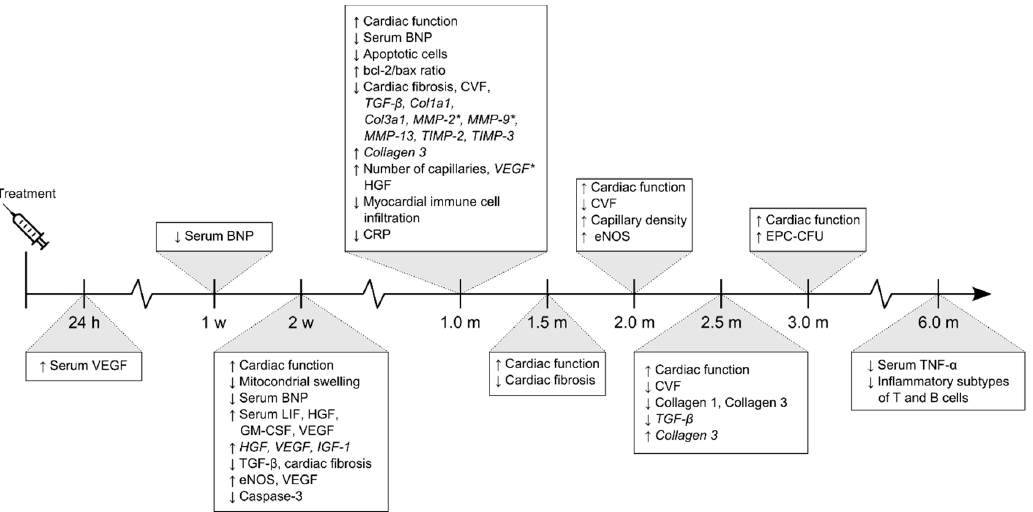
Figure 4. Timeline illustrating functional and molecular outcomes investigated in the included studies. Five studies investigated molecular outcomes within the first four weeks after treatment, whereas the remaining investigated at one-month post treatment or later. Gene expression in italics, asterisk (*) depicts dual protein and gene expression, ↑ represents and upregulation and ↓ a downregulation . Abbreviations; Brain natriuretic peptide (BNP), Leukocyte inhibitory factor (LIF), Granulocyte- macrophage colony-stimulating factor (GM-CSF), Insulin-like growth factor-1 (IGF-1), Collagen Type III Alpha 1 Chain (Col3a1), C-reactive protein (CRP).